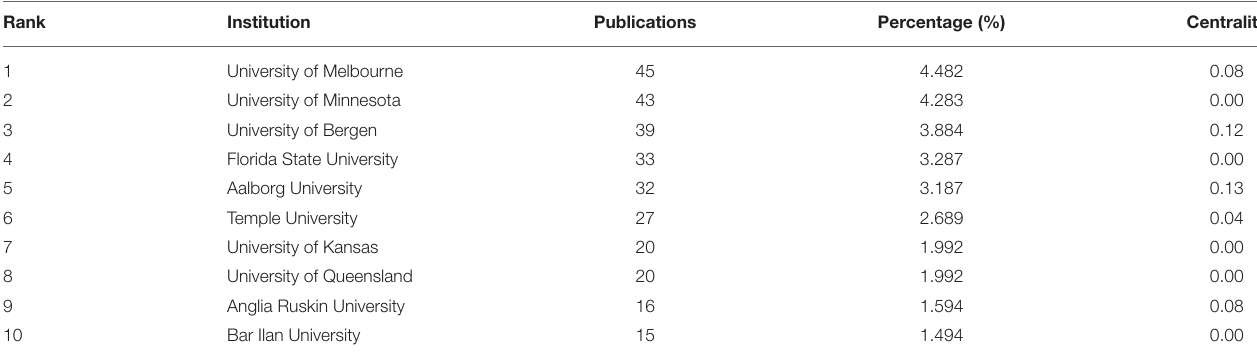
TABLE 2 | Top 10 institutions that contributed to publications in the music therapy field.